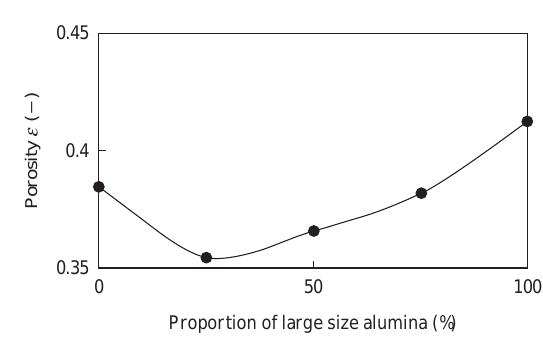
Effect of particle size blended powder on porosity of alu- mina particle layer after heat treatment at